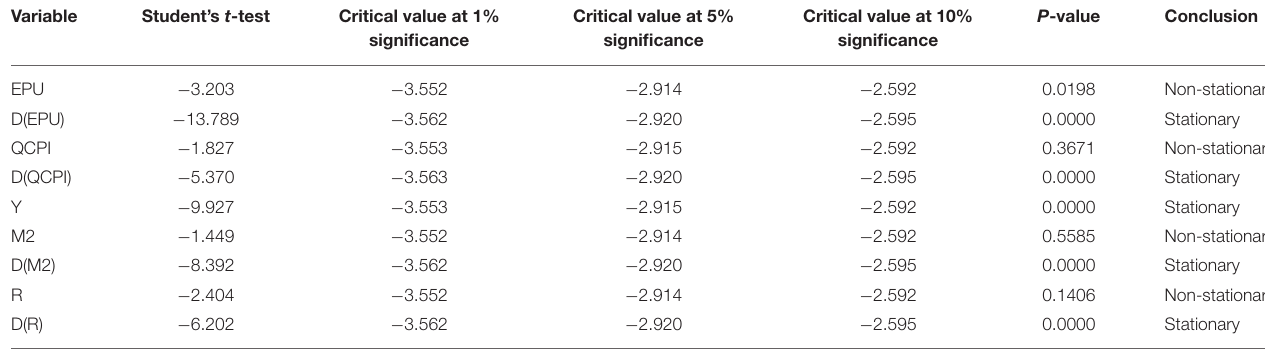
TABLE 1 | ADF test results of the